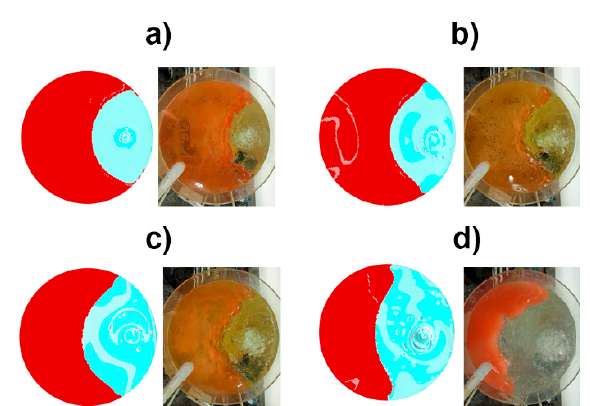
Figure 5. Comparison between experimental and numerical views of the slag eye opening area for an oil thickness 0.02 m. ( a ) Flow 5.33 × 10 − 5 m 3 /s. ( b ) 1.07 × 10 − 4 m 3 /s. ( c ) 2.14 × 10 − 4 m 3 /s. ( d ) 4.28 × 10 − 4 m 3 /s.